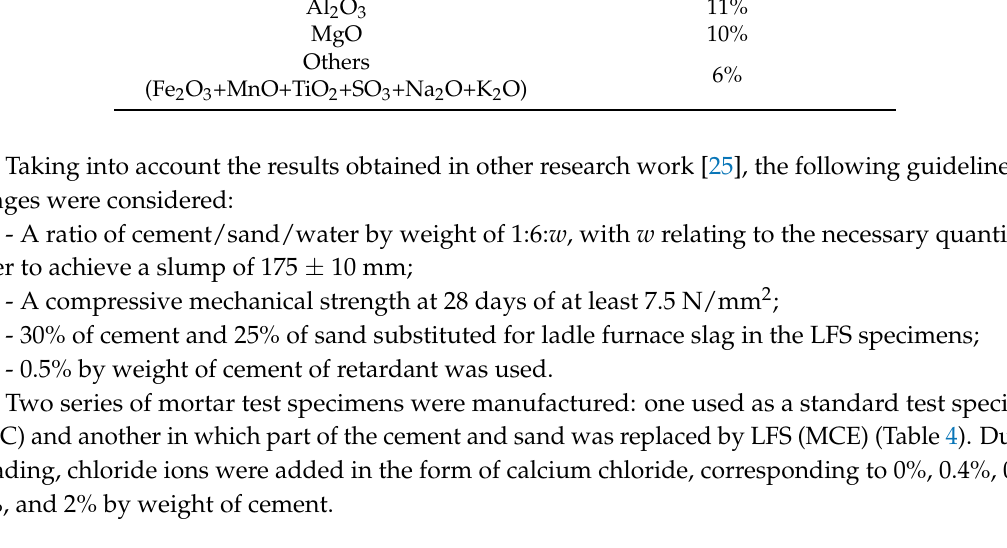
Table 4. Dosages of the samples with and without